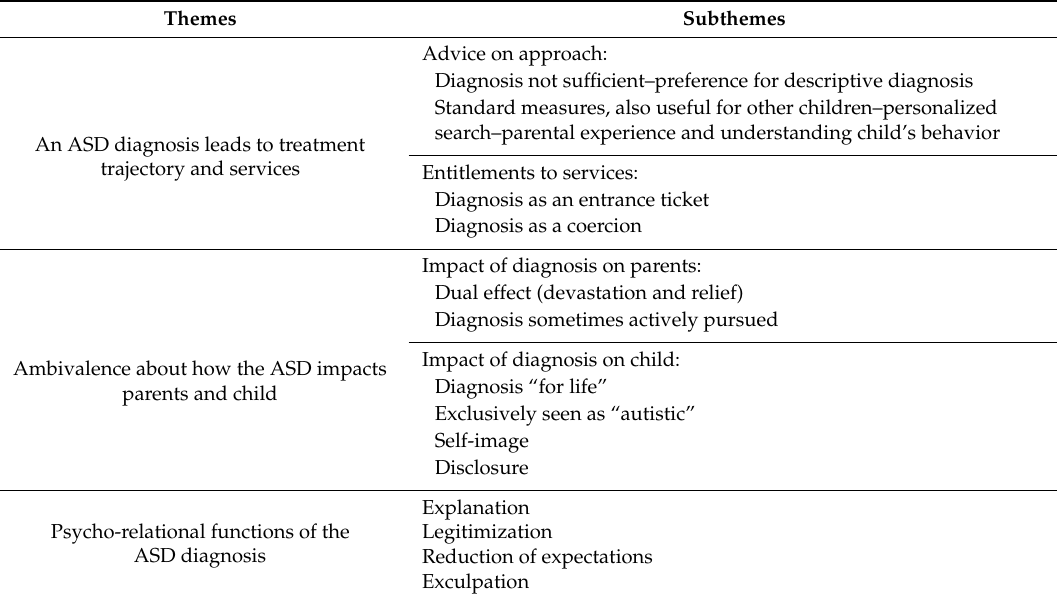
Table 2. Physicians’ experiences of the implications of an ASD